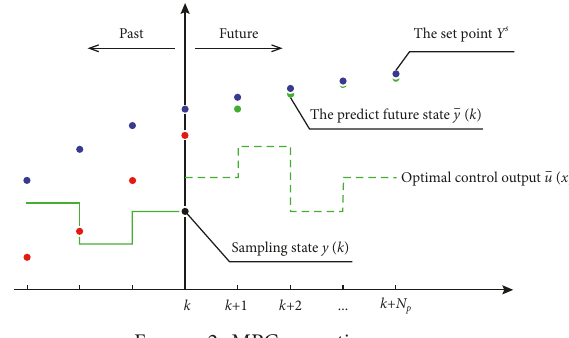
Figure 2: MPC execution